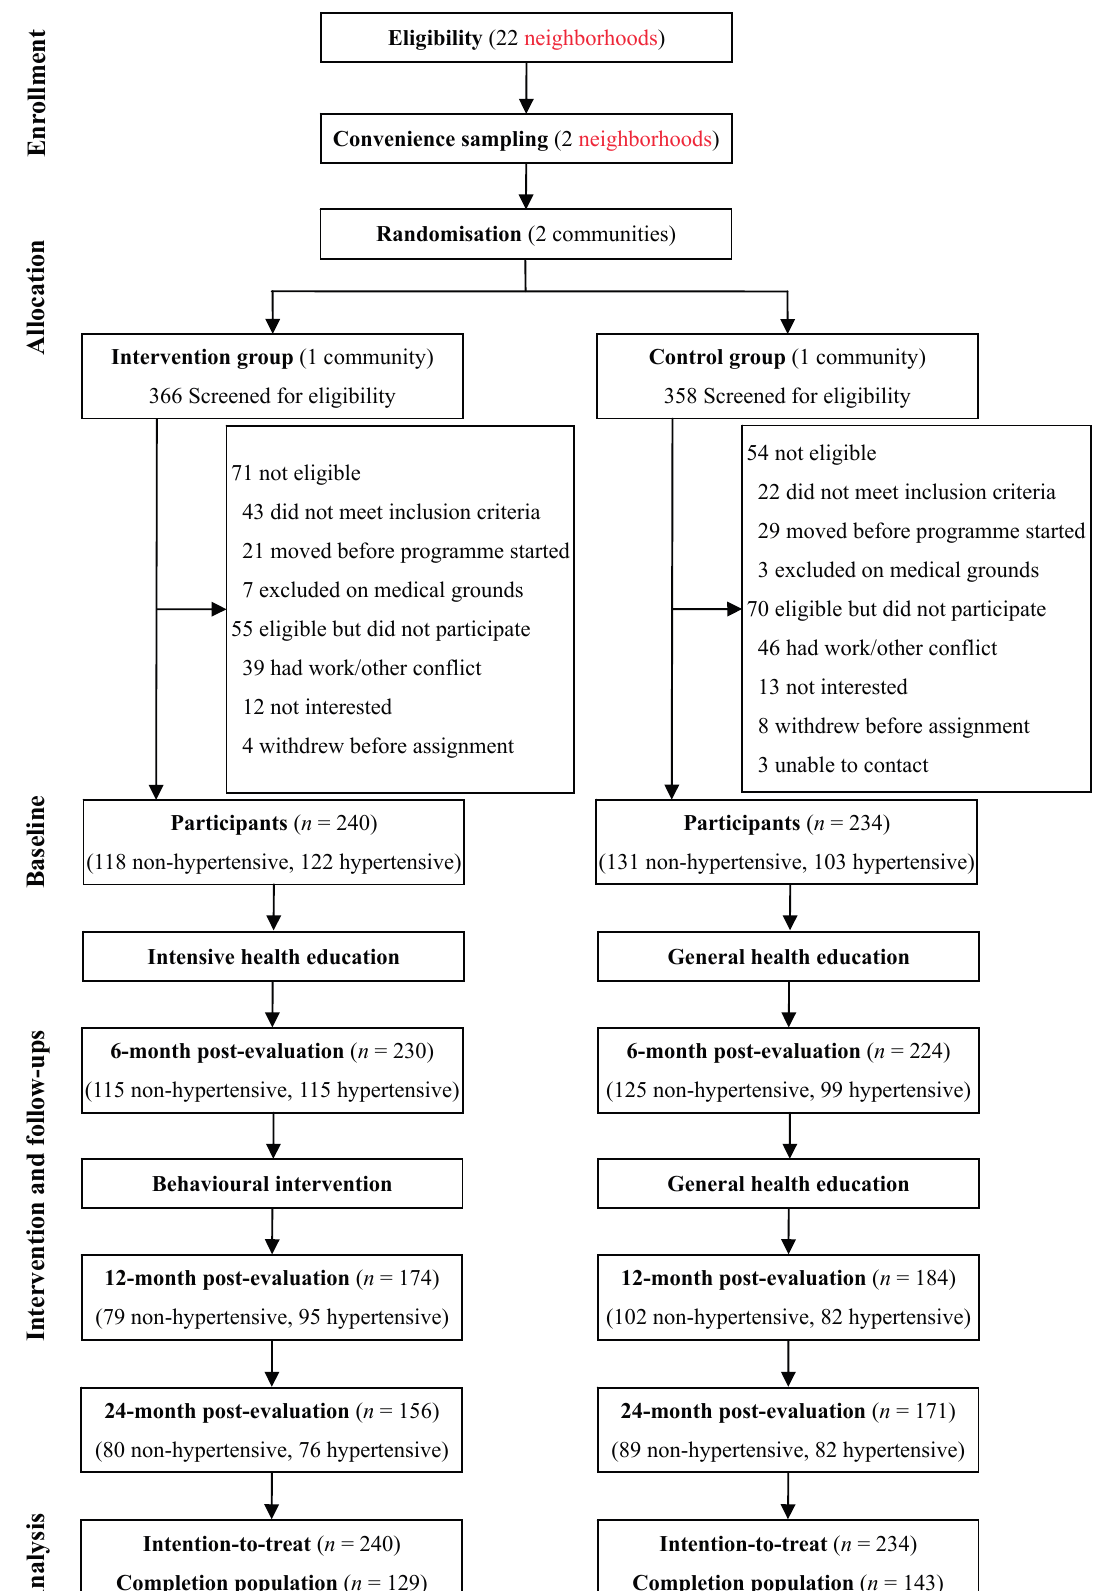
Figure 1. Study design and participant